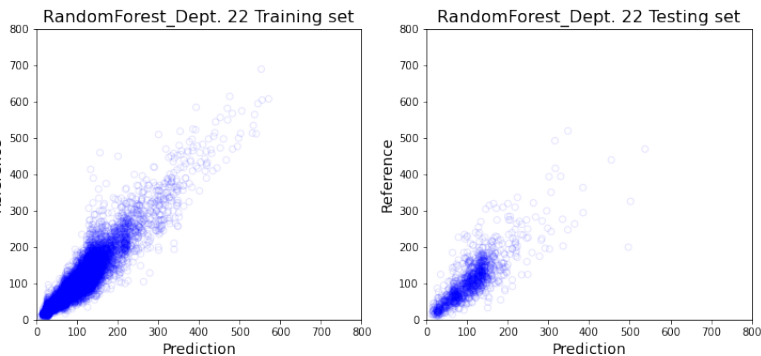
Figure A5. Model Performance of RandomForest on Dept.22. The visualization of training and testing data for department specific model on department 22 with Random Forest.